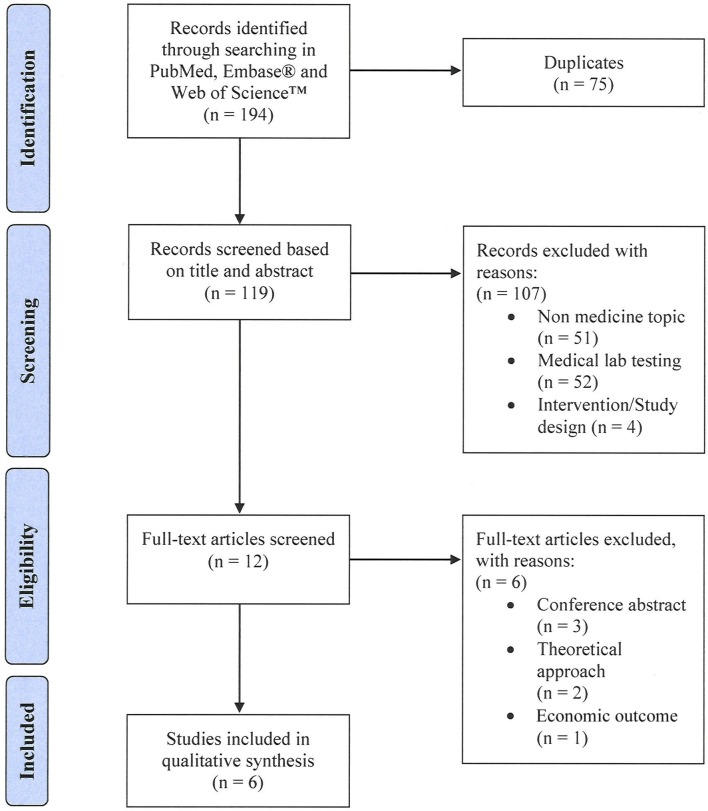
Study flow diagram.